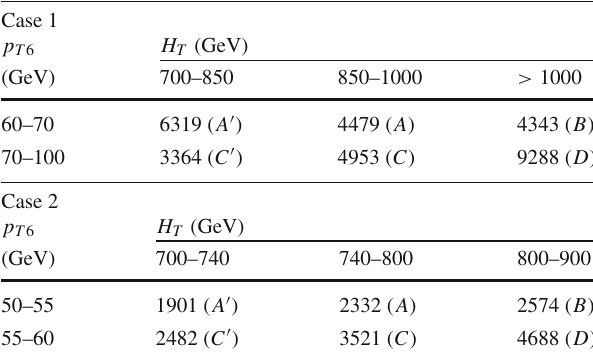
Table 3 Number of entries in various H T and p T 6 regions in t ¯ t + multi − jets samples for the two cases considered in Fig. 5. The label beside each entry indicates the region each entry corresponds to